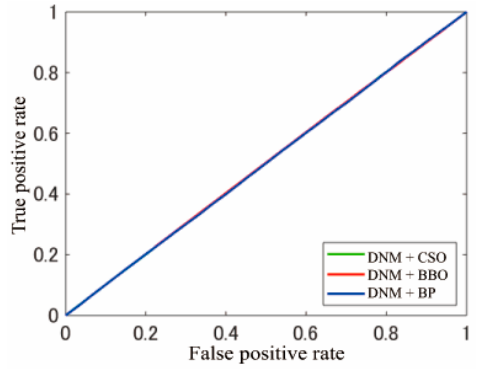
Figure 10. ROC of each method in F2.